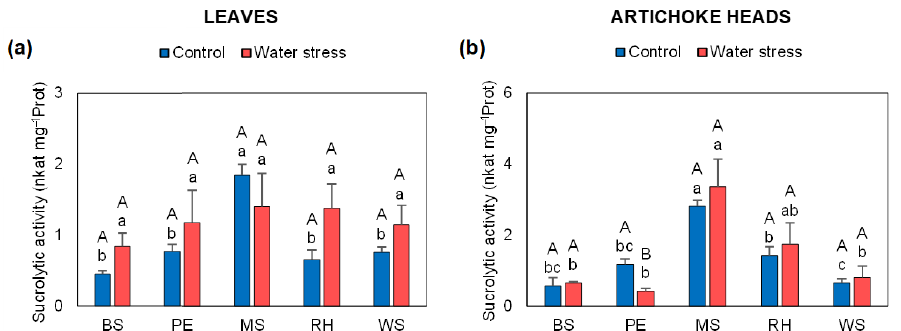
Figure 3. Sucrolytic activity in ( a ) leaves and ( b ) heads of artichoke plants of the commercial Symphony variety non-mulched or subjected to different mulching treatments and cultivated under control (well-watered) and water-stress (70% ETc) conditions. Bars show the means of five plants ± standard error. Different capital letters indicate significant differences due to the water-stress treatment, while different small letters show significant differences among mulching treatments according to Tukey’s test ( p ≤ 0.05). Abbreviations used: bare soil (BS), polyethylene mulch (PE), mushroom-substrate-based hydromulch (MS), rice-hull-based hydromulch (RH), and wheat-straw-based hydromulch (WS).